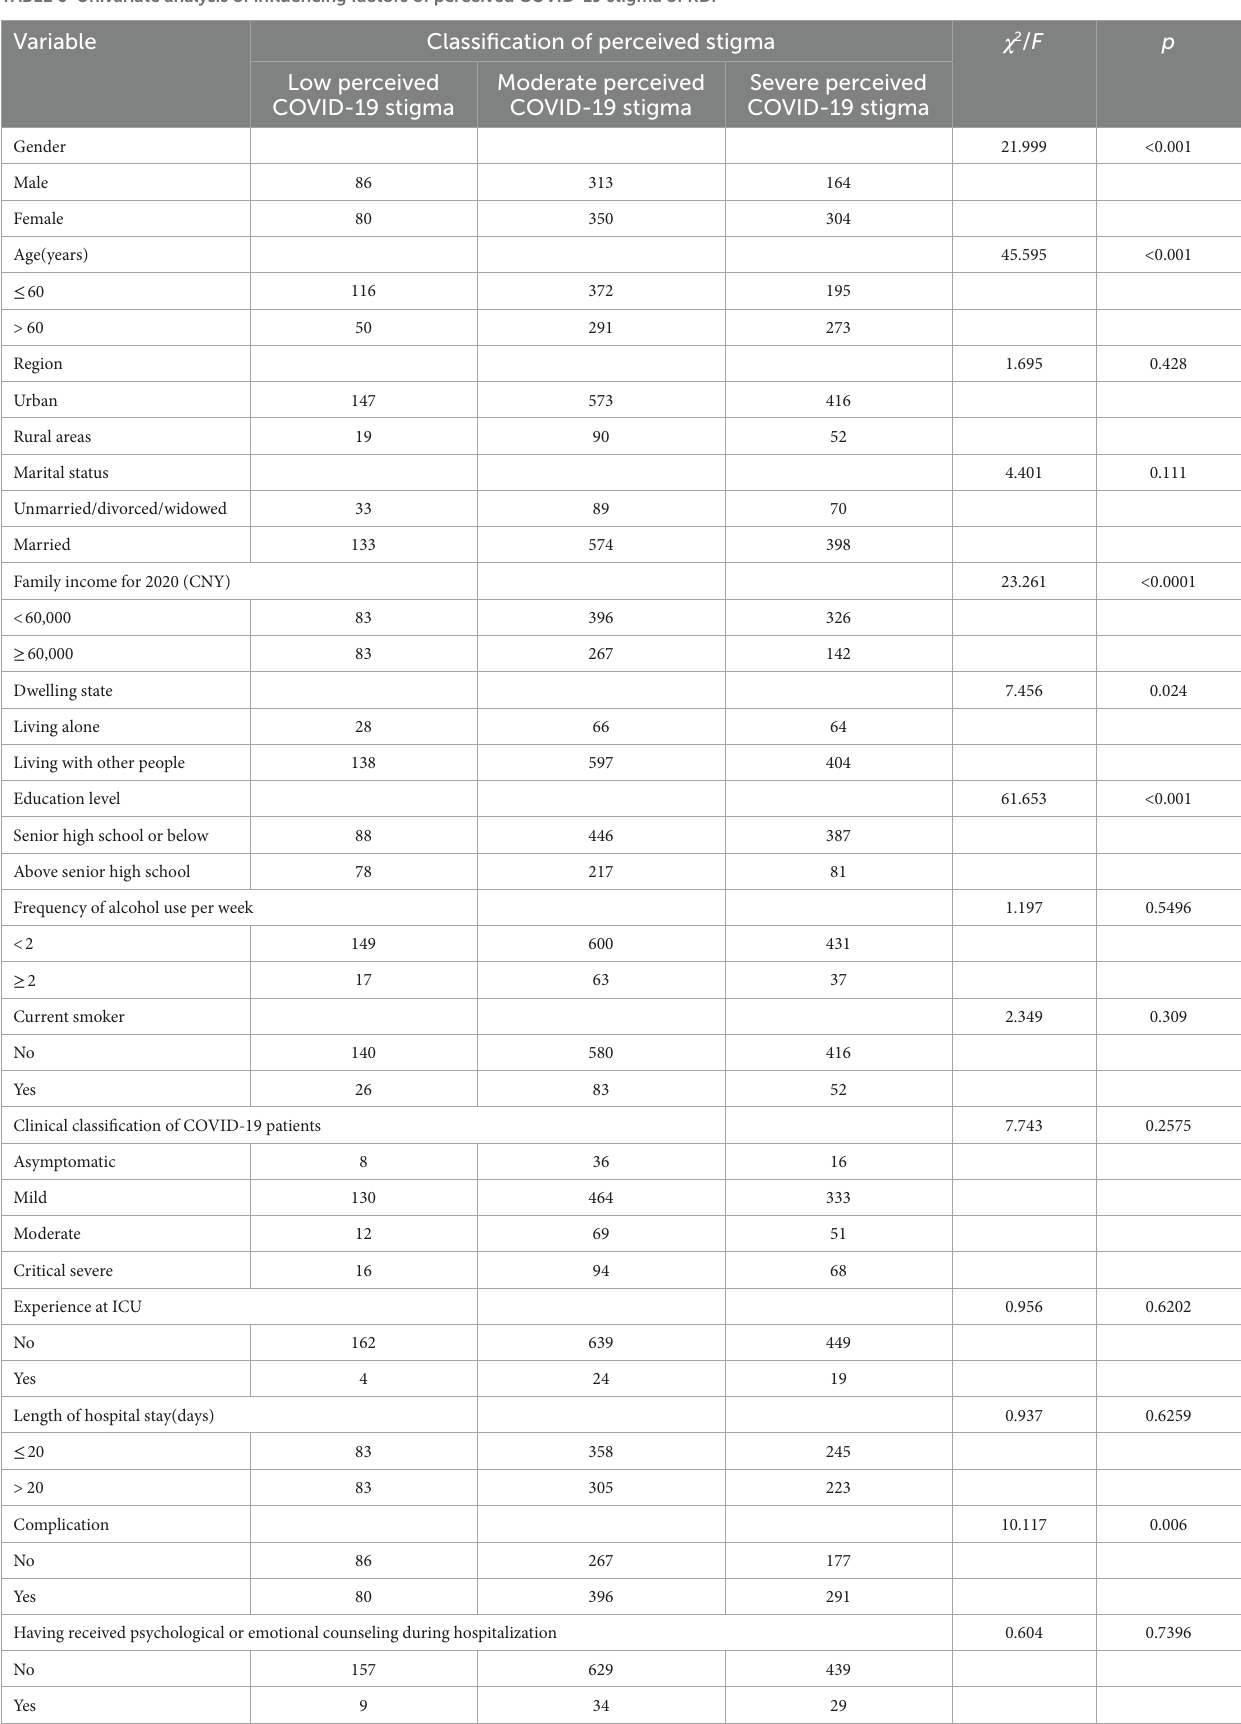
TABLE 6 Univariate analysis of influencing factors of perceived COVID-19 stigma of RD. Variable Classification of perceived